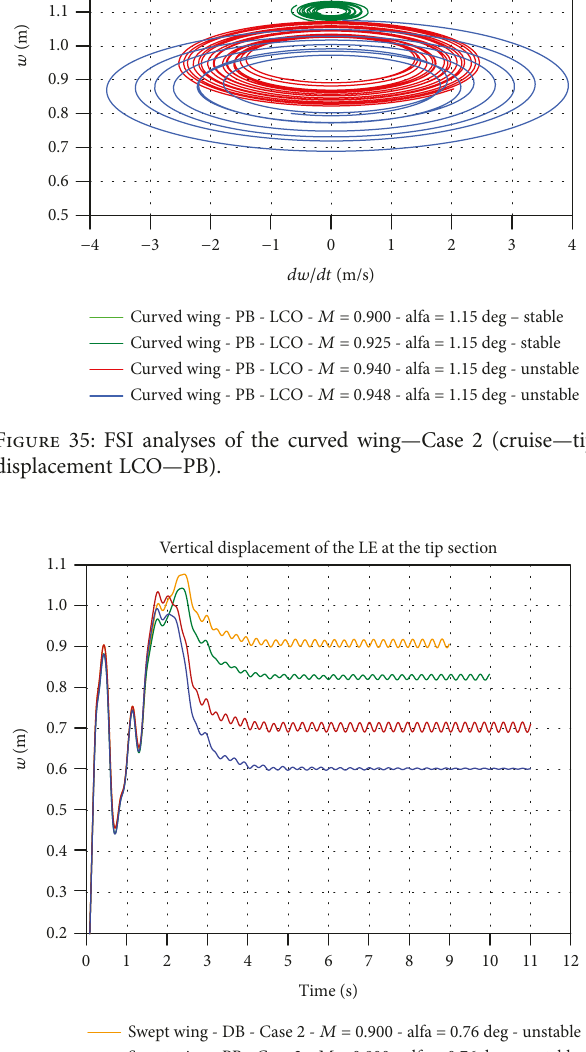
Figure 34: FSI analyses of the swept wing — Case 2 (cruise — tip displacement LCO — PB).